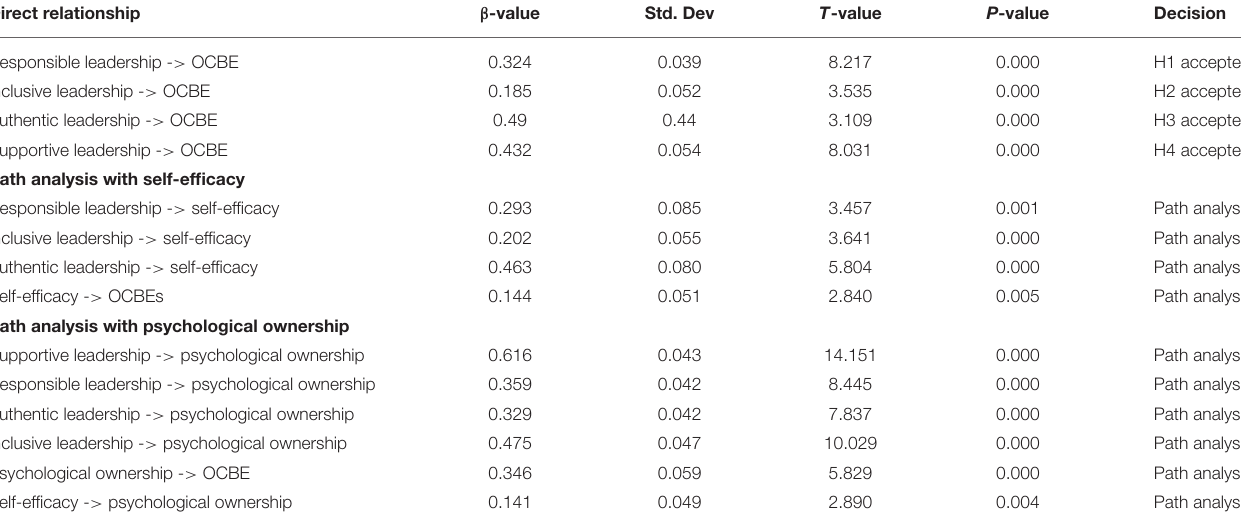
TABLE 5 | Hypothesis testing